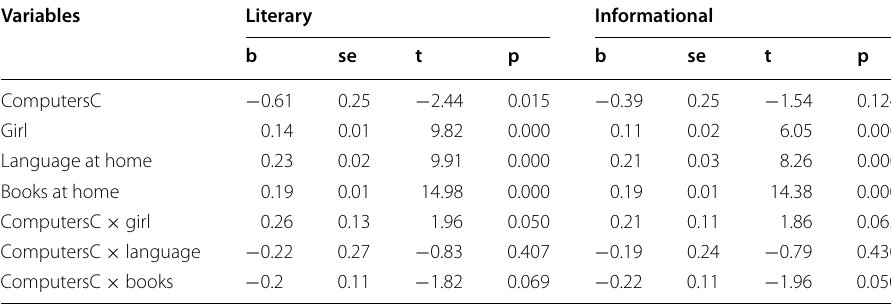
The model estimated corresponds to the C1INT model in Table 3